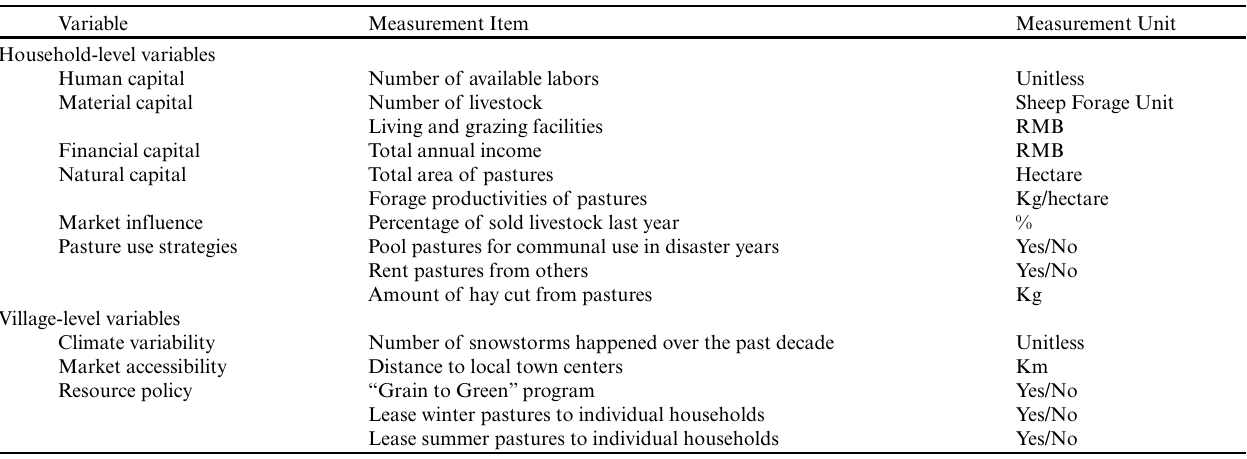
Table 1 . The variables measured at household and village levels used for modeling adaptation